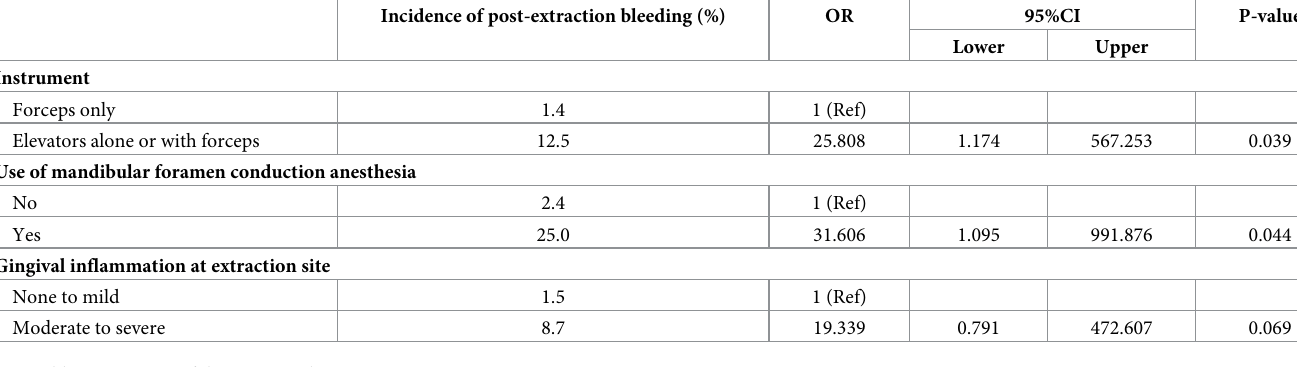
Table 5. Multivariate analysis of risk factors for post-extraction bleeding events (rivaroxaban).